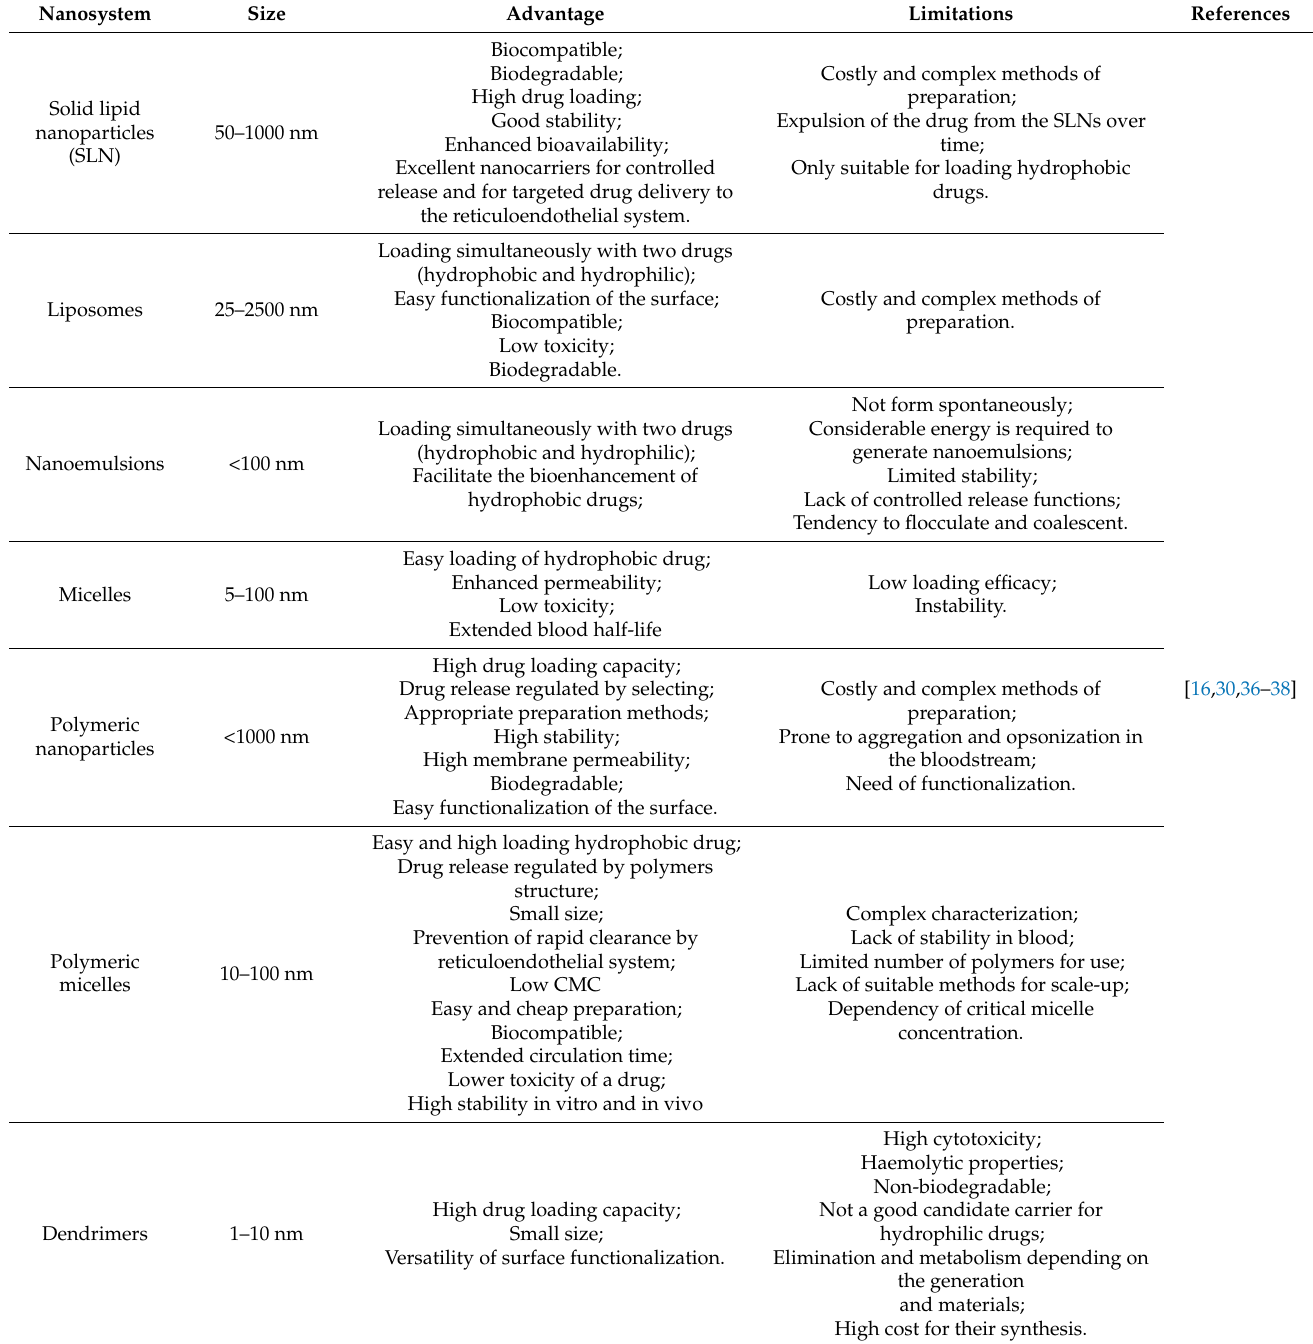
Table 2. Summary of the properties of the various nanosystems as well as their advantages and